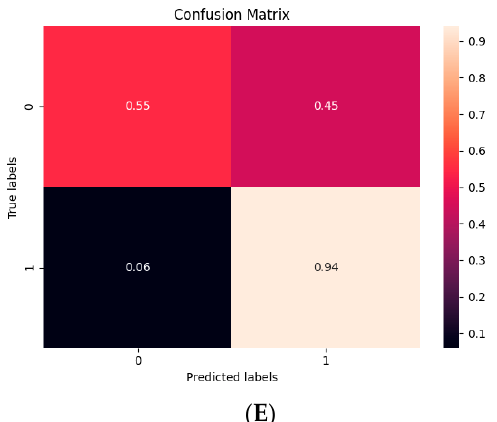
Figure 5. An example of an OSCC ex vivo FCM image with manually annotated cancerous regions and automated prediction. The interpretation of images ( A – E ) is the same as in Figure 4. An entire heatmap and segmentation mask was compared with the experts’ annotations. We can observe a less exact recognition of smaller annotations.